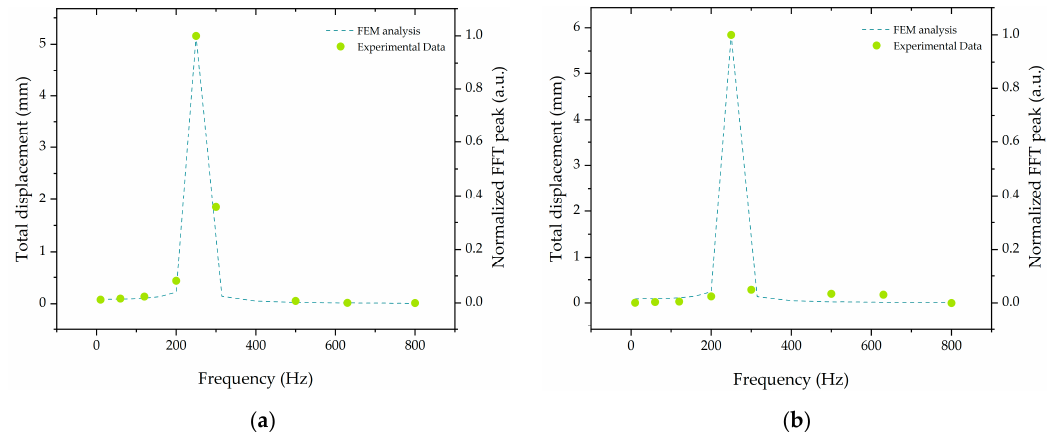
Figure 3. Cantilever displacement calculated by the FEM analysis in terms of applied frequency and experimental results for the normalized FFT peak for the ( a ) vertical and ( b ) horizontal direction.